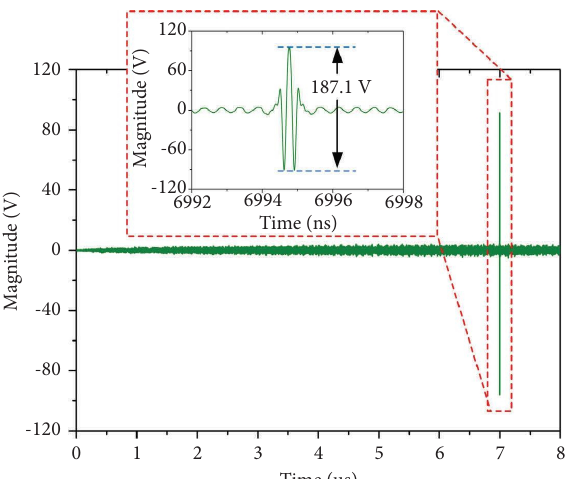
Figure 7: Te obtained simulated USP signal by using the improved simulation model is shown in Figure 3 with the copper material.